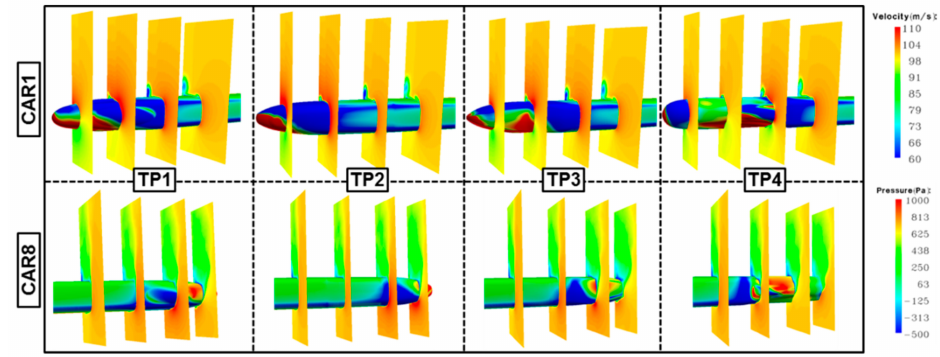
Figure 21. Velocity contours of different sections and the pressure contours of the train body (head section: x = − 99 m, x = − 95 m, x = − 90 m, x = − 85 m; tail section: x = 85 m, x = 90 m, x = 95 m, x = 99